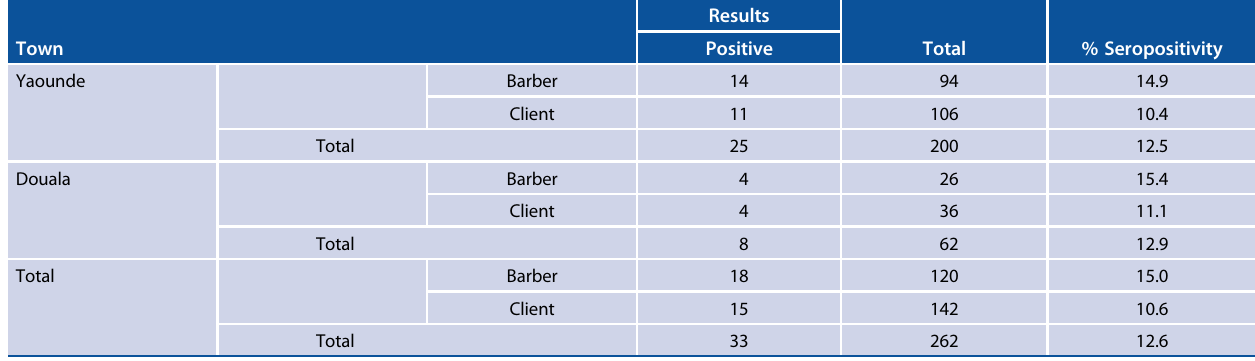
Table 1: Distribution of the HBV-positive participants in Yaounde and Douala